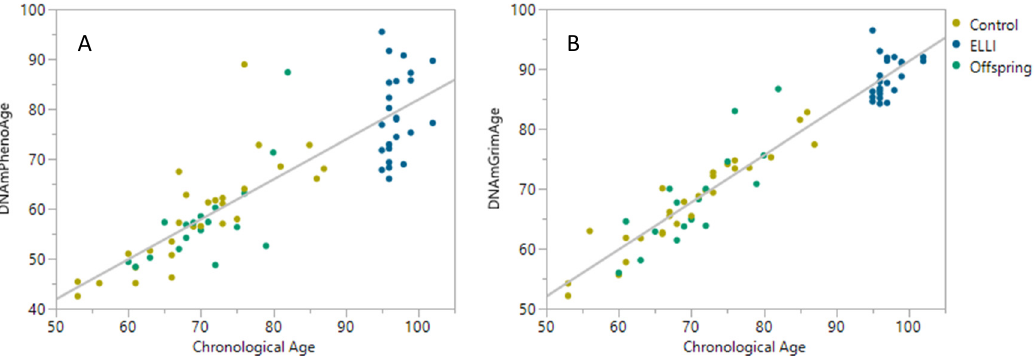
Figure 2. Comparison of actual age and two age clocks. DNAmGrimAge and DNAmPhenoAge calculated by applying methylation beta values to DNAm online tool [37]. N control = 28, N ELLI = 24, and N offspring = 18.